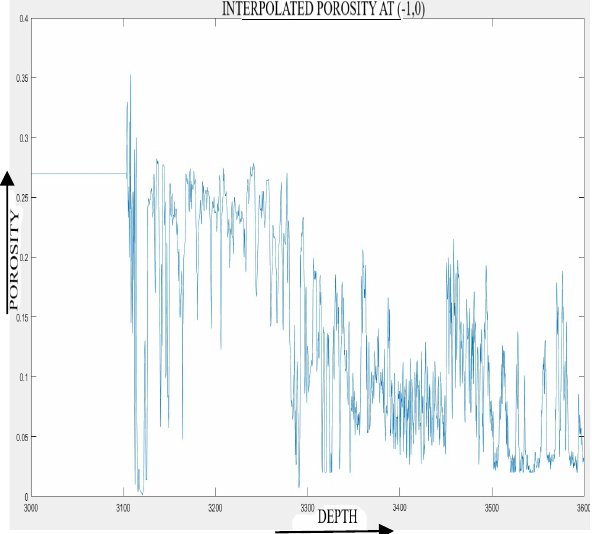
Figure 3. Interpolated porosity(y-axis) at (-1,0) concerning the depth in km. (x-axis)